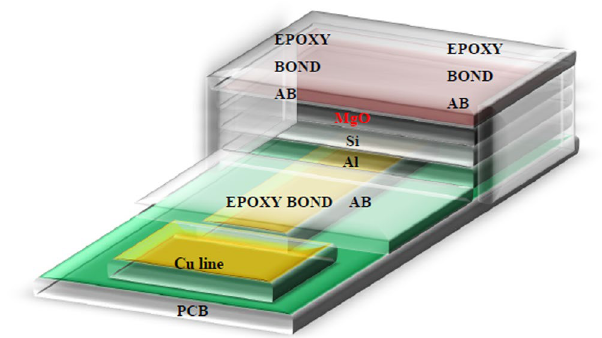
Figure 1. MgO EIS structure.